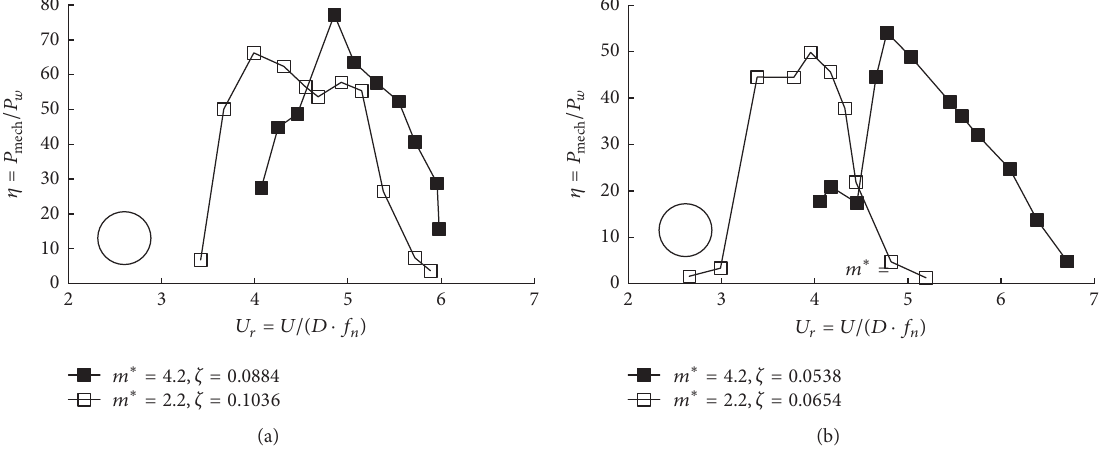
Figure 13: The influence of the mass ratio 𝑚 ∗ on the transfer ratio 𝜂 . (a) Case 1 . (b) Case 2